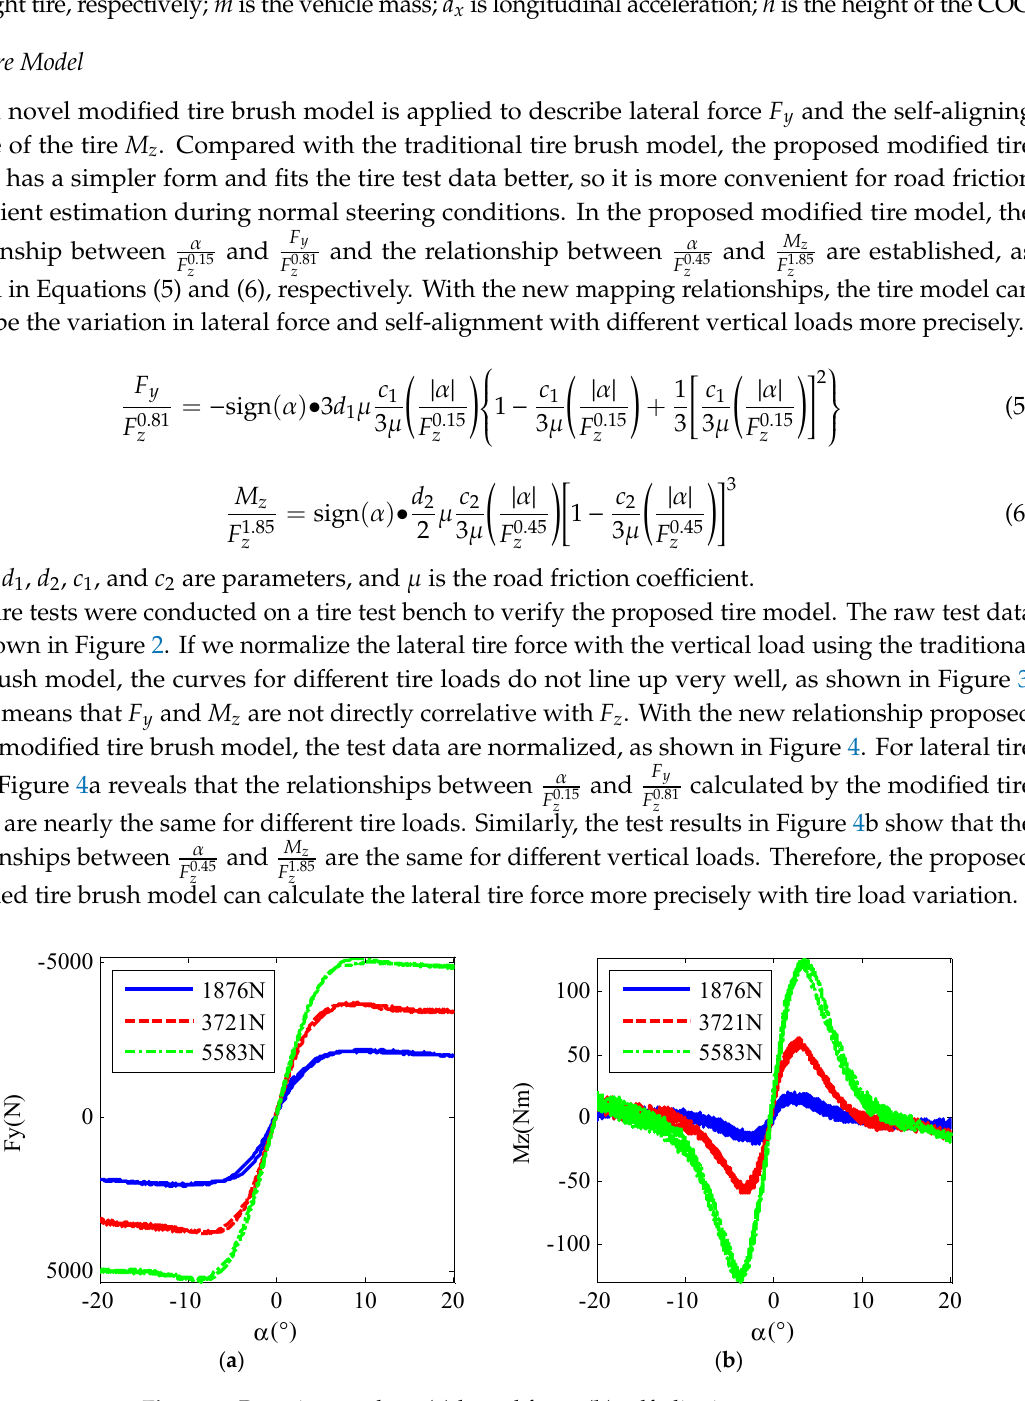
( b ) Figure 3. Normalization of tire test data with the original tire brush model: ( a ) lateral force; ( b ) self-aligning torque.